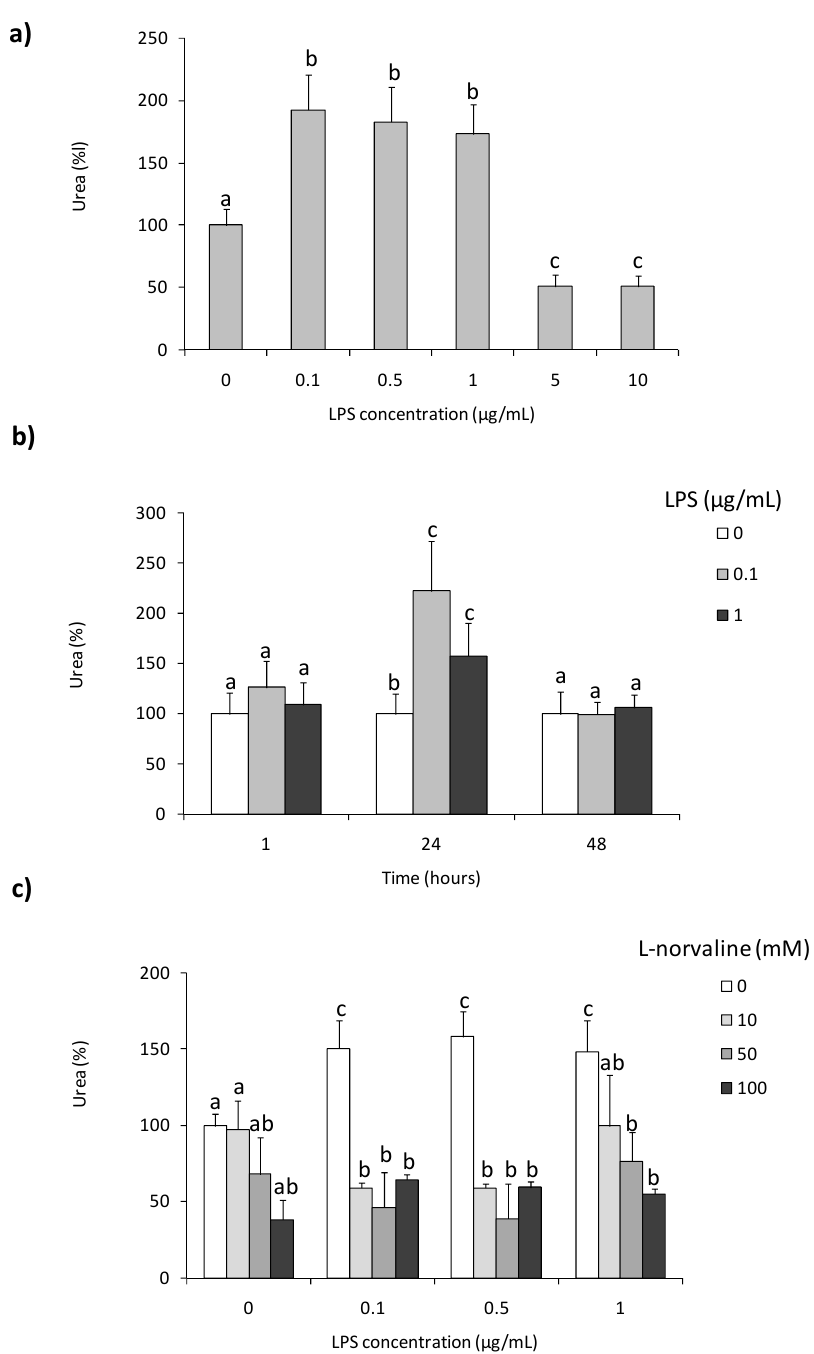
Figure 1. Effects of in vitro stimulation with lipopolysaccharide on arginase activity in Eisenia andrei coelomocytes. Cells were in vitro treated with lipopolysaccharide (LPS) (0–10 µ g/mL) for 24 h ( a ) or with LPS (0–1 µ g/mL) for 1, 24, or 48 h ( b ). Some cells 1 h before stimulation were treated with arginase activity inhibitor ( L -norvaline, 10–100 mM) ( c ). Arginase activity was determined as urea content and showed as % of control (arginase activity in unstimulated cells = 100%). Mean + standard errors (SE), n = 8–16. Mean values that are significantly different are not assigned a common letter (e.g., a vs. b or b vs. c) according to one-way analysis of variance (ANOVA) (at p < 0.05).